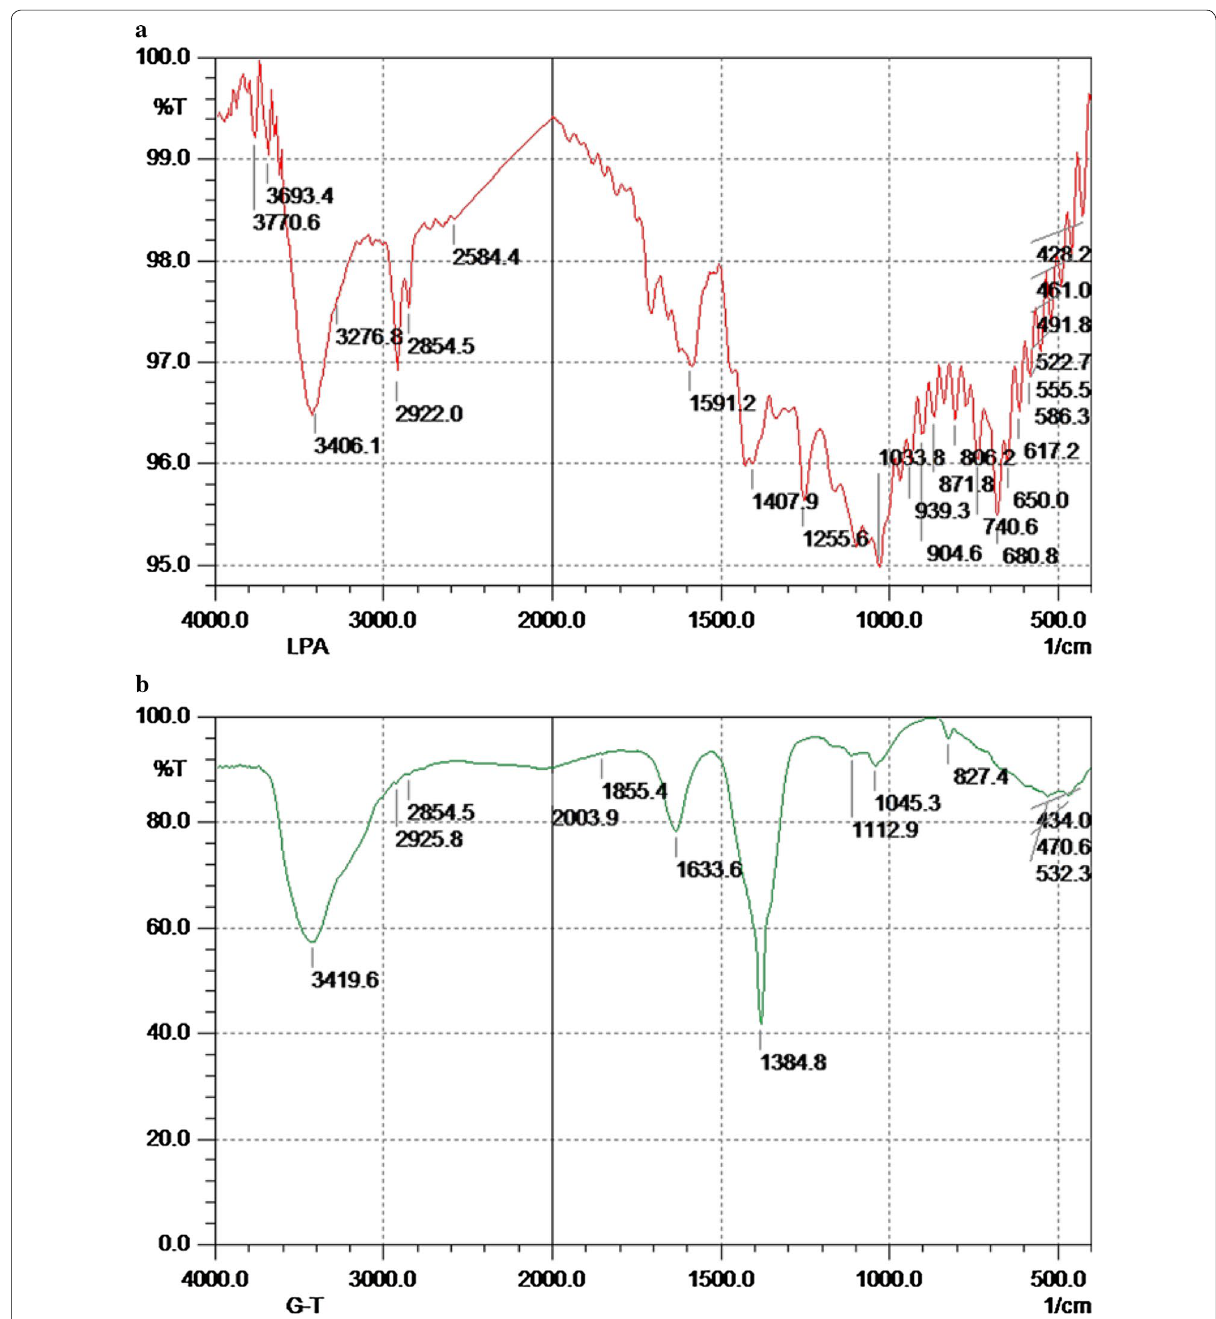
Fig. 3 FT-IR spectra of ( a ) ligand LPa, ( b ) Au-LPa large